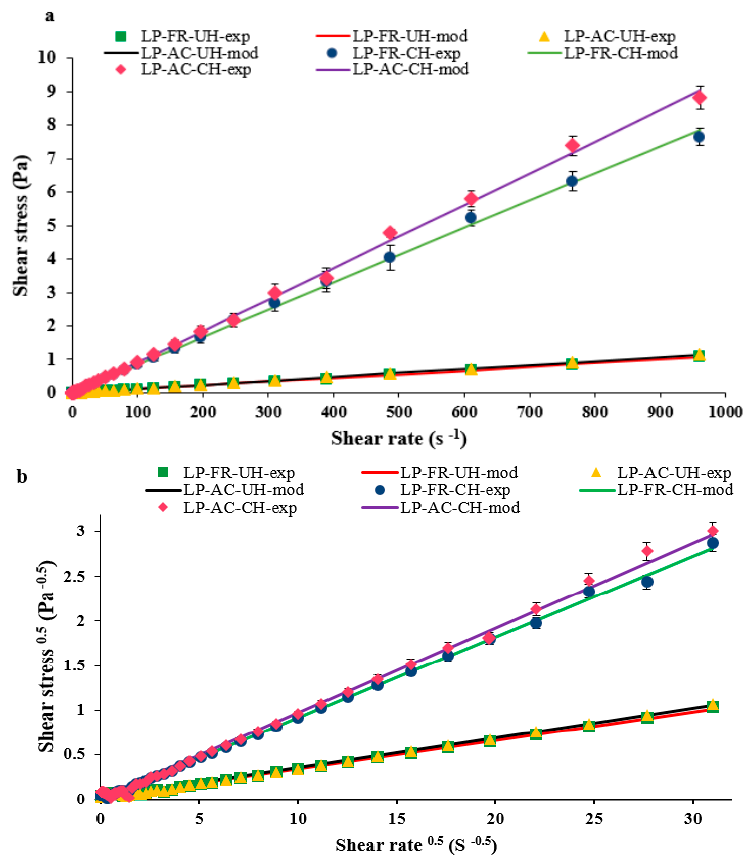
Figure 2. Flow behavior of nanoliposomes with various formulations: ( a ) Flow curves of shear stress and fitted data with the power-law model; ( b ) experimental data fitted with Casson model (square root of shear stress against the square root of shear rate).